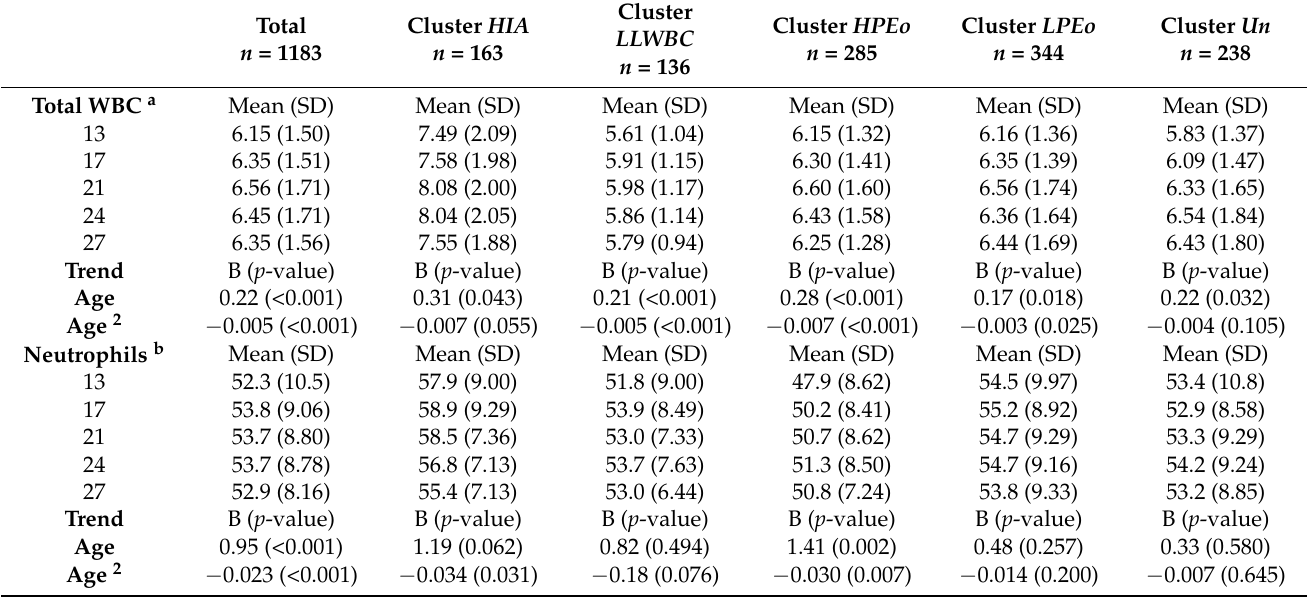
Table A1. Description of the total and differential white blood cells (WBC) at 13, 17, 21, 24 and 27 years of age according to the